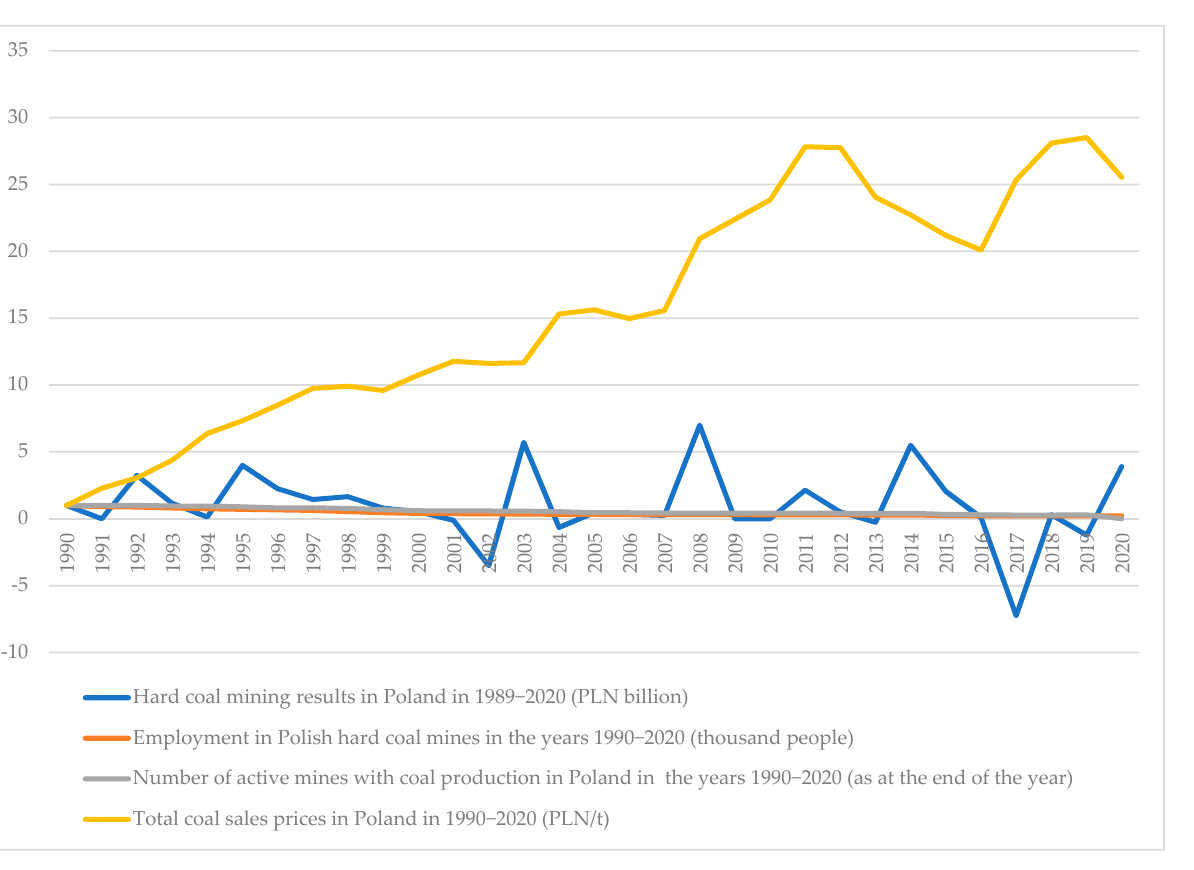
Figure 2. Changes of employment, hard coal mining, number of active mines and total coal sales in Polish coal sector. Source: own analysis based on Statistic Poland.